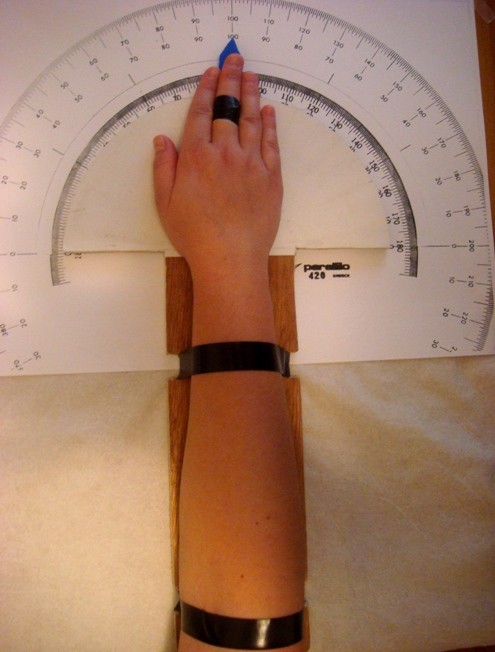
Right hand in the neutral position.